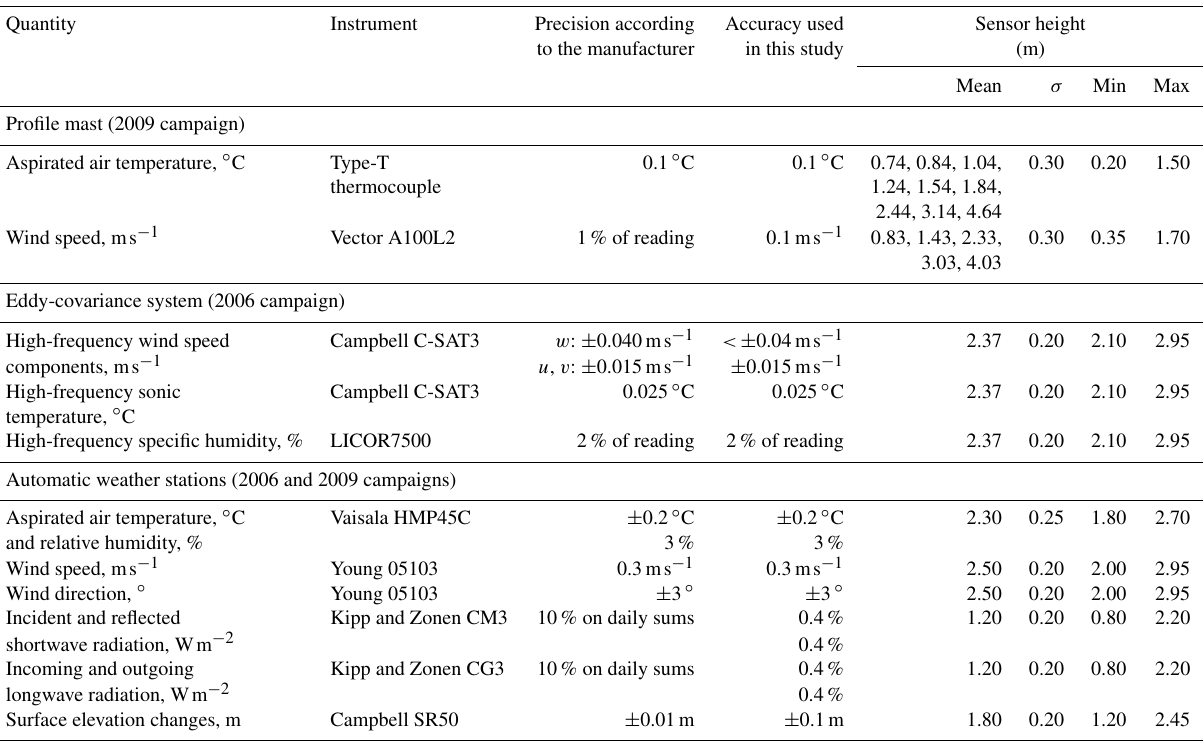
Table 1. Characteristics of sensors from the automatic weather stations (AWS-G and AWS-M), the eddy-covariance (EC) and the profile mast. We present the random errors on the measurements, as provided by the manufacturer and the random measurement errors that we used to quantify uncertainties on the turbulent fluxes. Minimum and maximum heights refer to the lowest measurement levels in the case of the profile data.